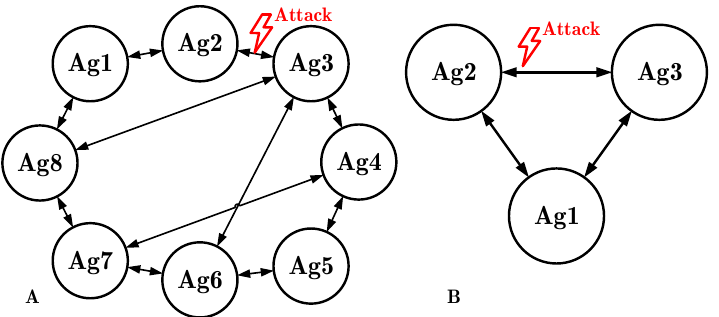
Figure 4. Graph topology: ( A ) eight boost agents for simulation scenario, and ( B ) three boost converters which communicate over the network for experimental